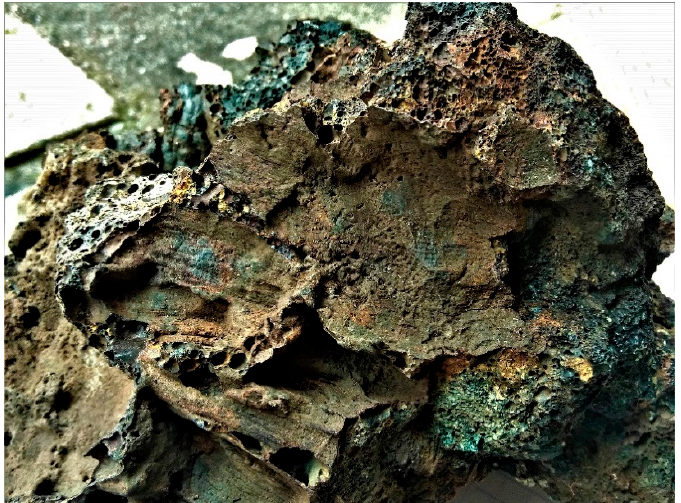
Figure 4. Block of vitrified rock with a potential wooden pole or timber imprint collected on the top hill of Serravuda.